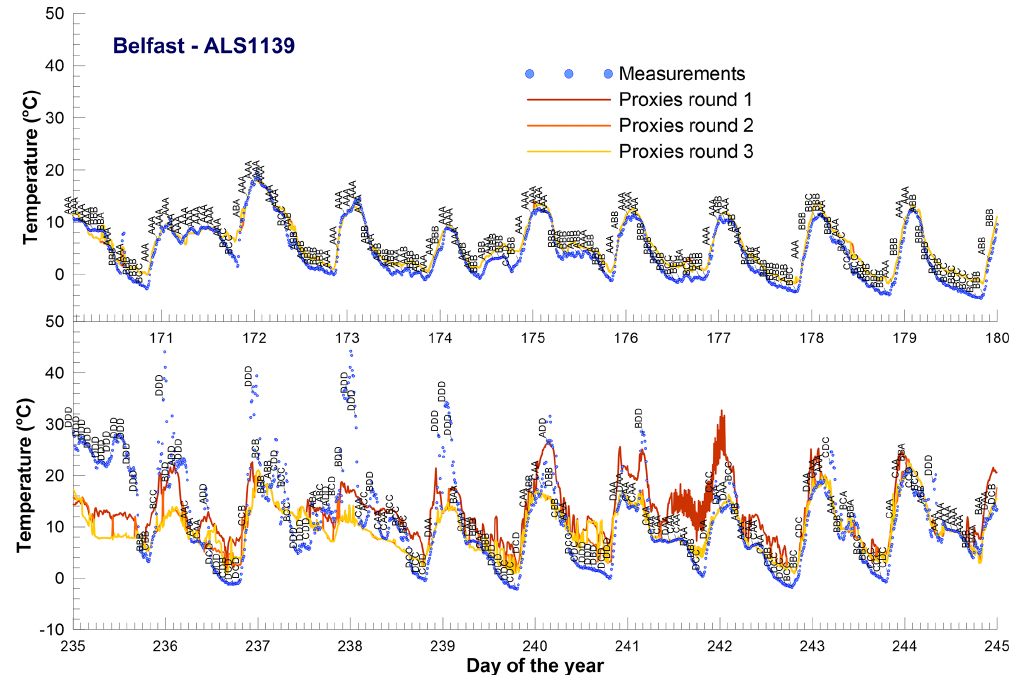
Figure 6. Two selected periods of temperature measurements at the Belfast AWS site (ALS1139) and the QA/QC label ascribed to each of the values. For clarity, only every 10th label is shown. The 10min proxy mean time series from each of the passes (brown: 1; orange: 2; yellow: 3) are also